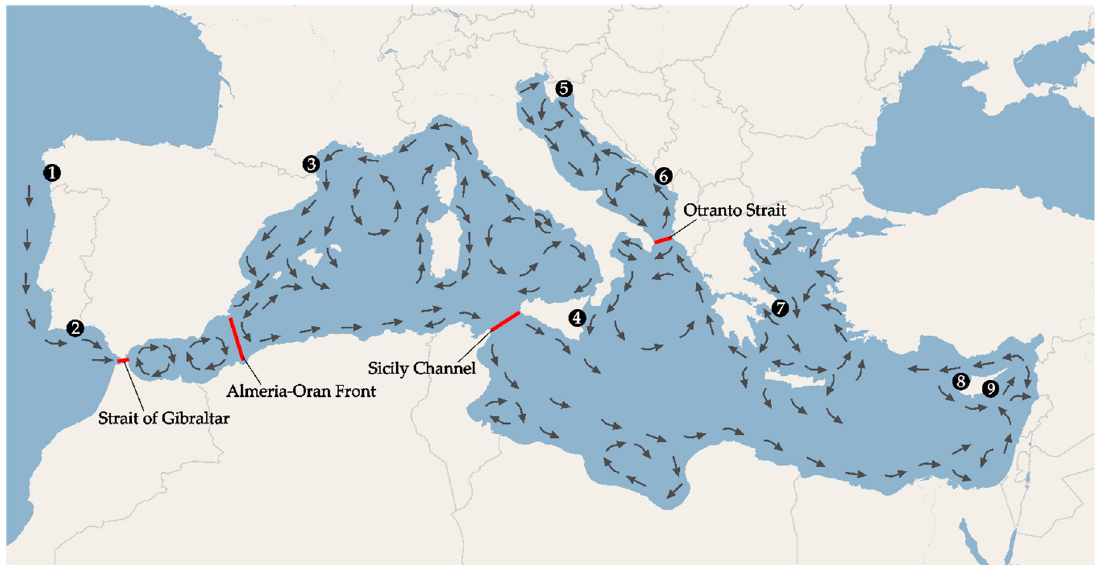
Figure 1. Map of the studied area, with sampling sites (black dots), main oceanographic barriers (red lines) and circulation of the main currents in the Mediterranean Sea (arrows). 1—Spain, 2—Portugal, 3—France, 4—Sicily, 5—Croatia, 6—Montenegro, 7—Greece, 8—Cyprus W (west), 9—Cyprus E (east).